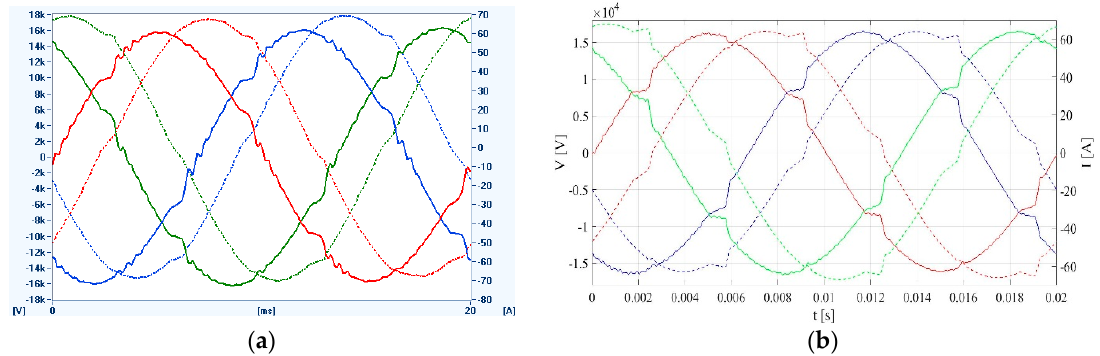
Figure 30. The voltages (full line) and the currents (chain line): ( a ) the measurement; ( b ) the simulation. The third load represents the higher harmonics, which were spread to the distribution grid from the three-phase full-wave rectifier with bridge connection. The individual dependencies of currents and voltages are shown in Figure